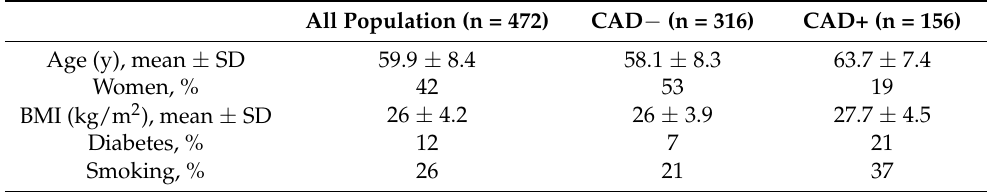
Table 1. Characteristics of the participants at inclusion